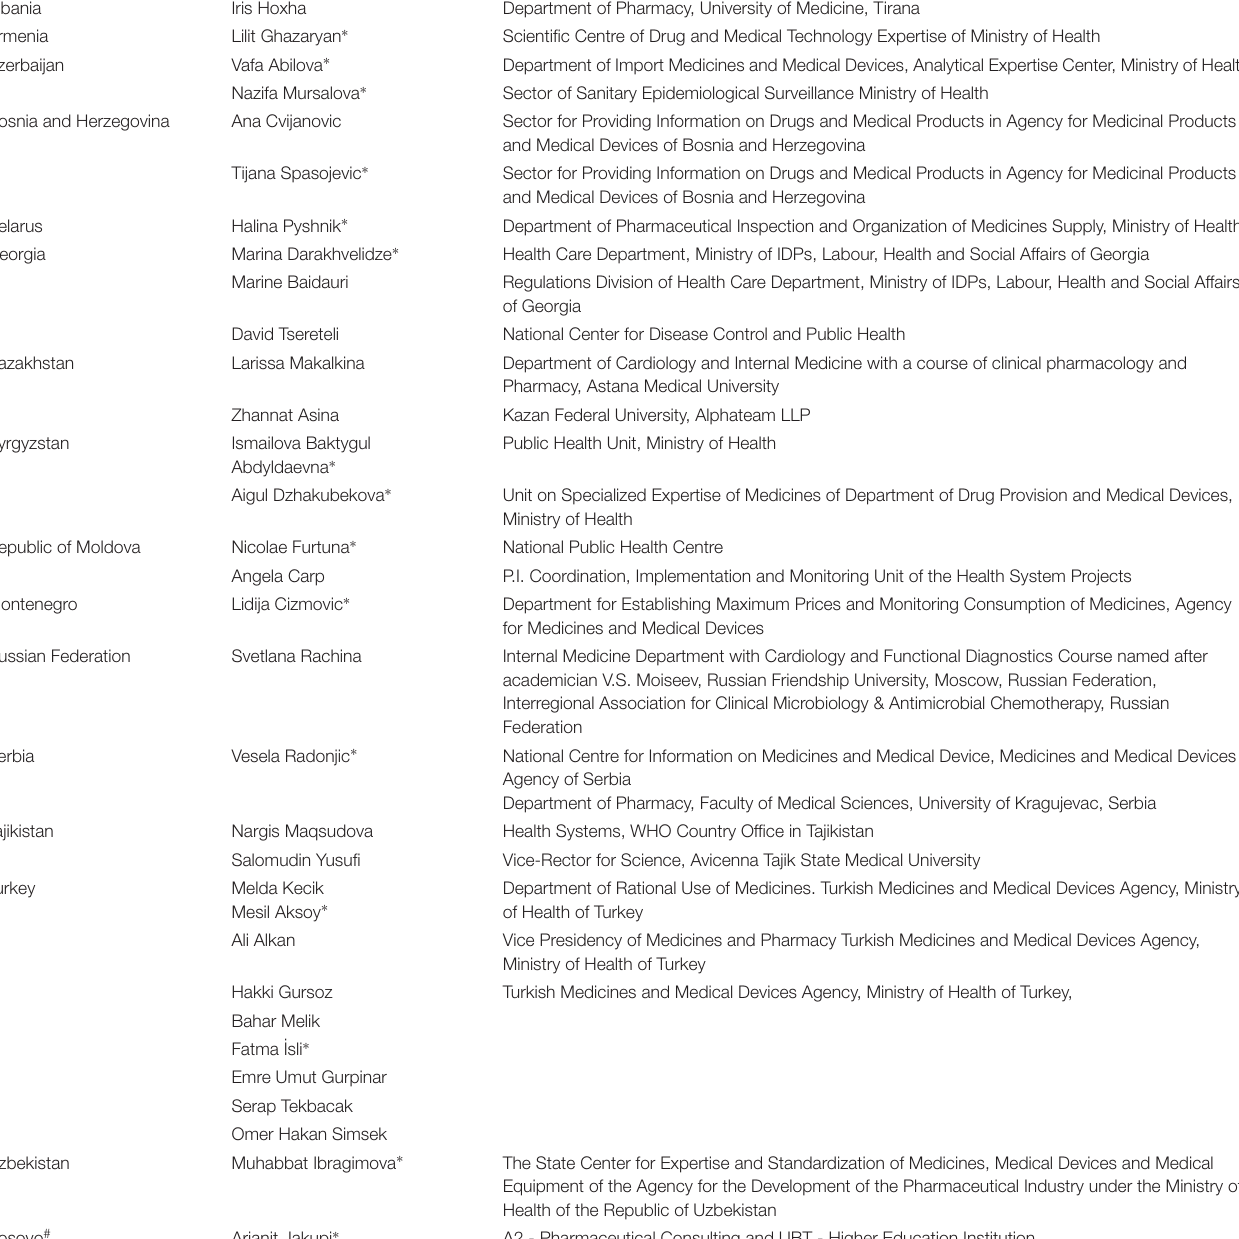
TABLE A1 | List of AMC focal points and contributors to the 2015 data